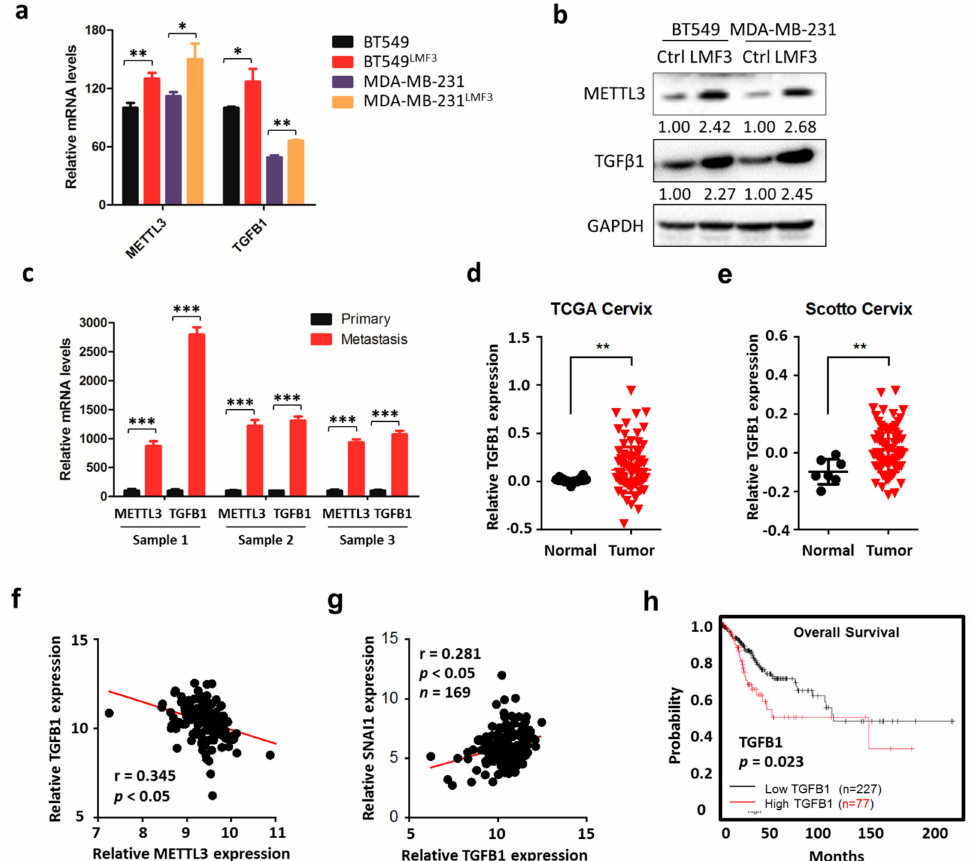
Figure 7. METTL3 / TGF β 1 / Snail axis regulates the in vivo progression of cancer. ( a ) Expression levels of METTL3 and TGFB1 mRNA in MDA-MB-231 LMF3 or BT-549 LMF3 cells and their corresponding parental cells were measured by qRT-PCR; ( b ) expression levels of METTL3 and TGF β 1 in MDA-MB-231 LMF3 or BT-549 LMF3 cells (LMF3) and their corresponding parental cells (Ctrl) were measured by Western blot. Band intensities of METTL3 and TGF β 1 were analyzed by ImageJ and are listed at the bottom of target bands; ( c ) expression levels of METTL3 and TGFB1 mRNA in primary tumors and metastasized tumors in lungs isolated from three MMTV-PyMT mice were measured by qRT-PCR. Data are presented as means ± SD from three technical replicates. ( d ) Expression of TGFB1 in cervical tumor tissues and normal tissues from Oncomine database: Ma Breast 4; ( e ) Expression of TGFB1 in cervical tumor tissues and normal tissues from Oncomine database: Cluck Breast; ( f ) Pearson correlation between TGFB1 and METTL3 in 169 cervical cancer tissues from the TCGA database; ( g ) Pearson correlation between TGFB1 and SNAI1 in 169 cervical cancer tissues from the TCGA database; ( h ) Overall survival (OS) in patients with high ( n = 227) versus low ( n = 77) levels of TGFB1 in cervical cancer patients plotted by the Kaplan–Meier method. Data in Figure 7a are presented as means ± SD from three independent experiments. Student’s t -test, *, p < 0.05; **, p < 0.01 compared with